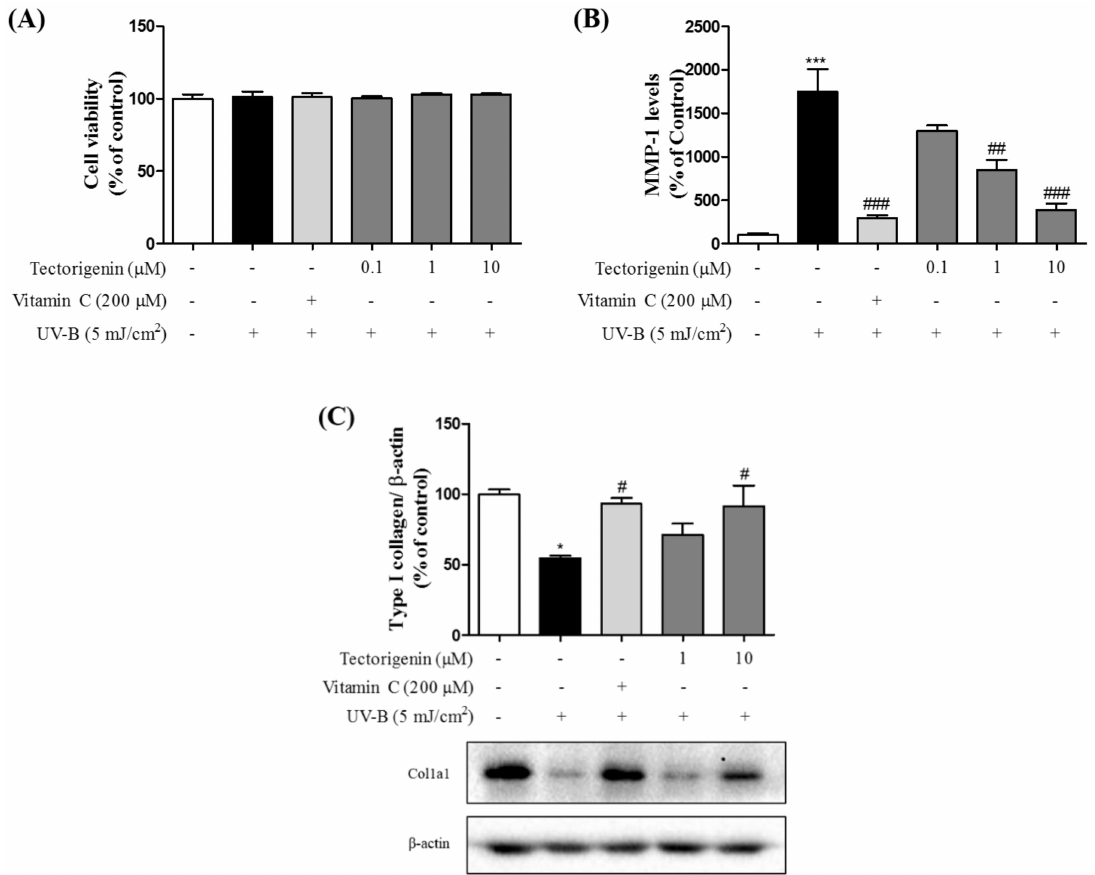
Figure 6. Inhibitory effects and the cytotoxicity of tectorigenin on UV-B-induced expression of MMP-1 and collagen degradation in HaCaT cells. The cells were irradiated with 5 mJ/cm 2 UV-B and treated with tectorigenin at 0.1, 1, and 10 µ M or vitamin C at 200 µ M for 24 h ( A , B ). The cells were irradiated with 5 mJ/cm 2 UV-B and treated with tectorigenin at 1 and 10 µ M or vitamin C at 200 µ M for 24 h ( C ). Cell viability was measured by an MTT assay. MMP-1 levels were measured by a human MMP-1 ELISA kit. Type 1 collagen levels were measured by a Western blot analysis. Values are given as the mean ± SEM. * p < 0.05, *** p < 0.001 versus control group, # p < 0.05, ## p < 0.01, ### p < 0.001 versus UV-B-only treated